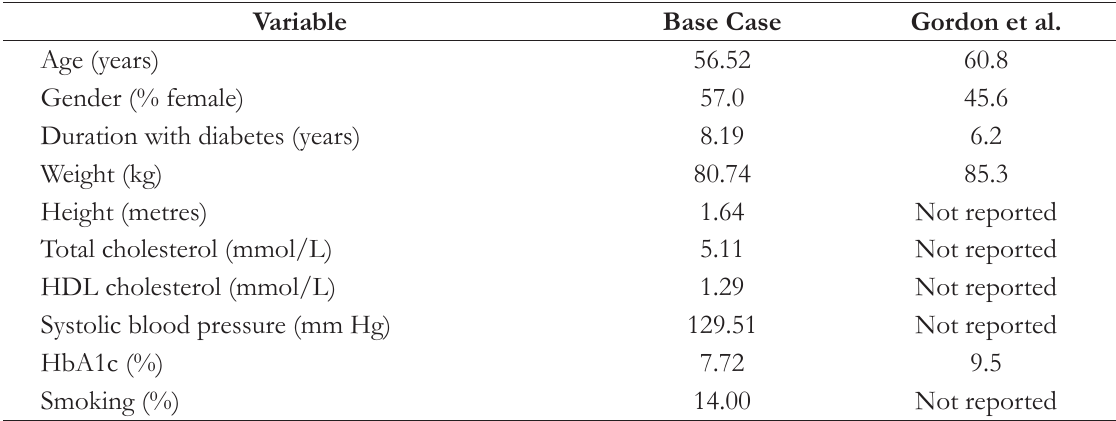
Table 1. Baseline Characteristics of T2DM Patients in Turkey for the Base Case, Reported by Gordon et al